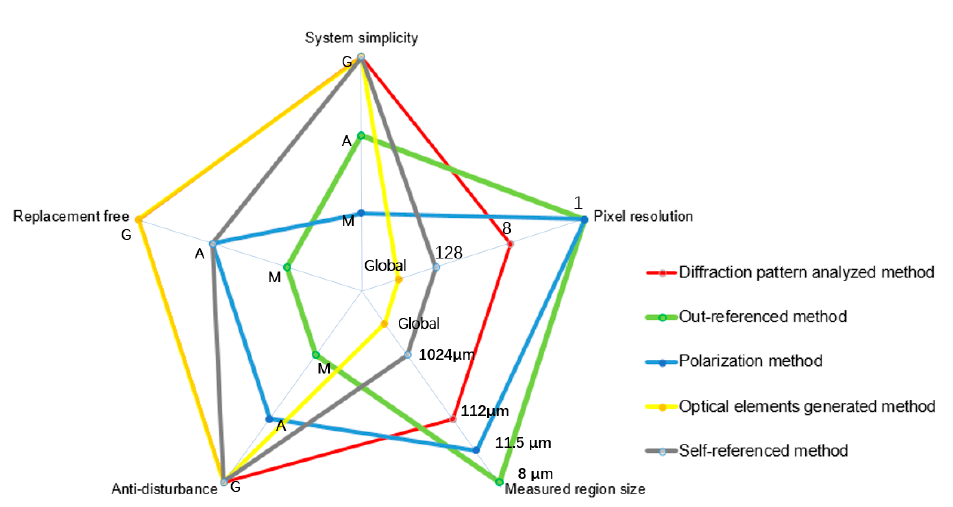
Figure 9. Comparison of features of calibration methods discussed in this review. System simplicity: simplicity of the calibration system; Pixel resolution: achieved spatial resolution in the discussed methods; Measured region size: calculated measured region size of nonuniformity measurement; Anti-disturbance: environment disturbance isolation; Replacement free: flexibility of deploying calibration procedure in an on-duty system without replacing the SLM. M: marginal; A: acceptable; G: good.